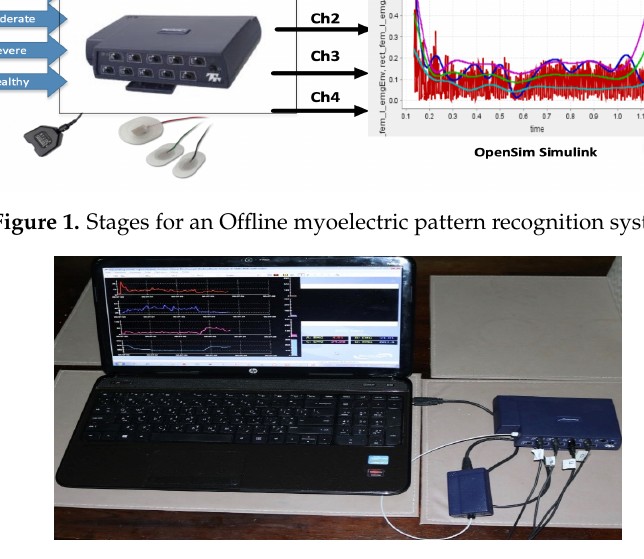
Figure 2. The hardware and software needed for the off-line